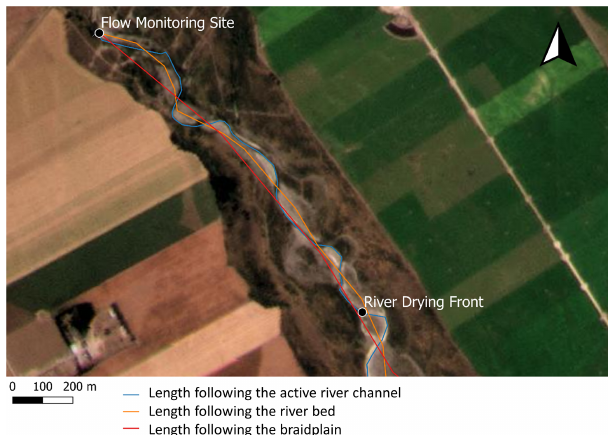
Figure A1. Wetted river lengths following the active river channel, the riverbed and the braidplain as considered in the study. The satel- lite image was taken on 27 January 2021, and the river drying front identified for this day is indicated in the image. Image credit to the Planet Team